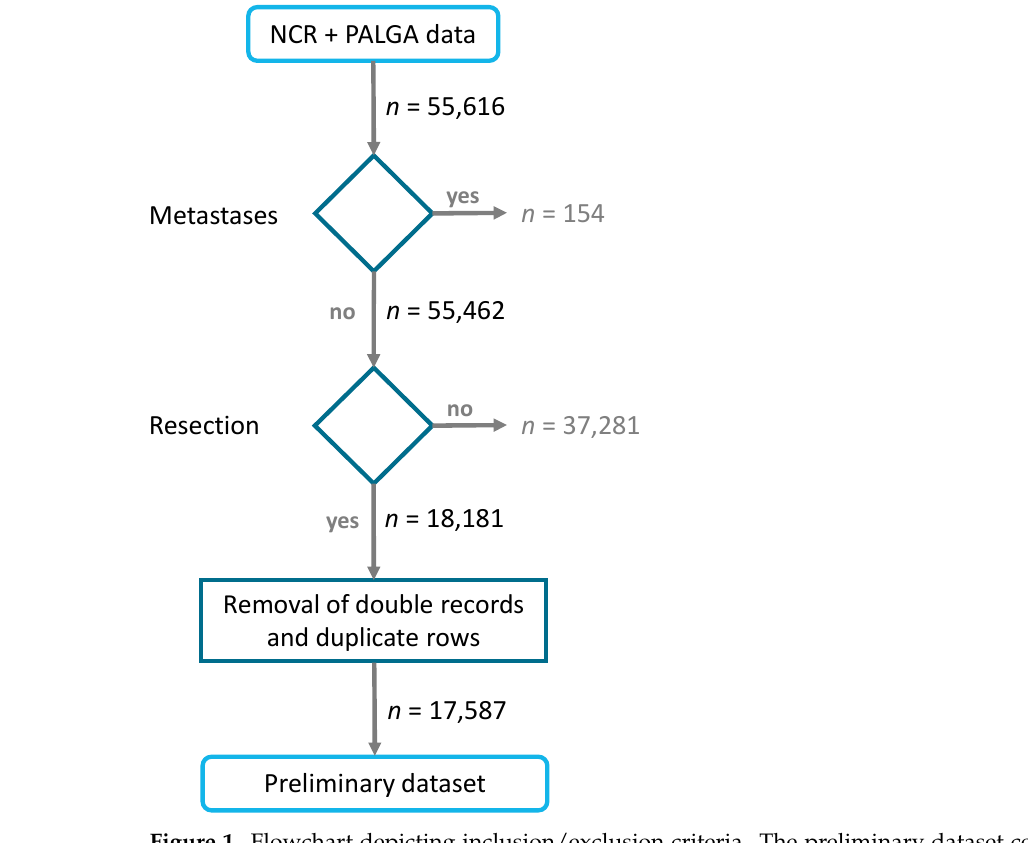
Figure 1. Flowchart depicting inclusion/exclusion criteria. The preliminary dataset consisted of 17,587 patients and 41 columns.